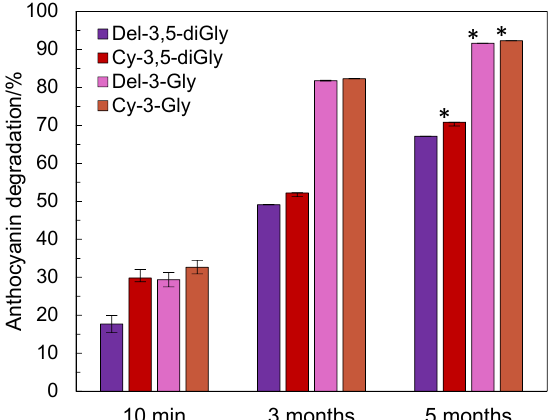
Figure 2. Degradation of anthocyanins (delphinidin-3,5- O -di-glucoside, cyanidin-3,5- O -di-glucoside, delphinidin-3- O -glucoside and cyanidin-3- O -glucoside) in pomegranate juice after thermal treatment (10 min 80 °C) and after long-term storage for either 3 or 5 months at 18 °C in sealed containers in the dark. Data are means ± SD. *, indicates dissimilarity versus 10 min—5 months degradation profile of delphinidin-3,5- O -di-glucoside (f2 < 50).